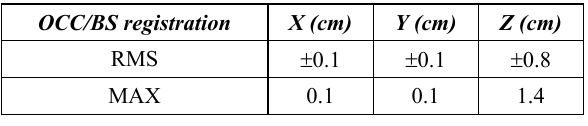
Table 10. Scans registration RMS and maximum deviation.